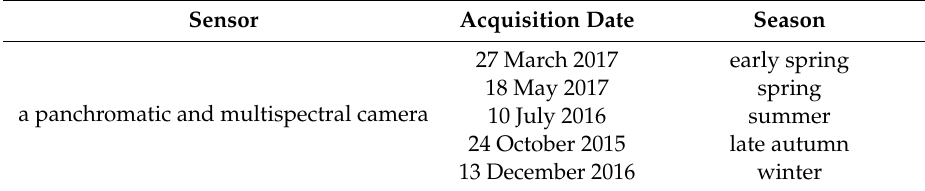
Table 1. Acquisition dates of the CBERS-04 imagery used in this study.